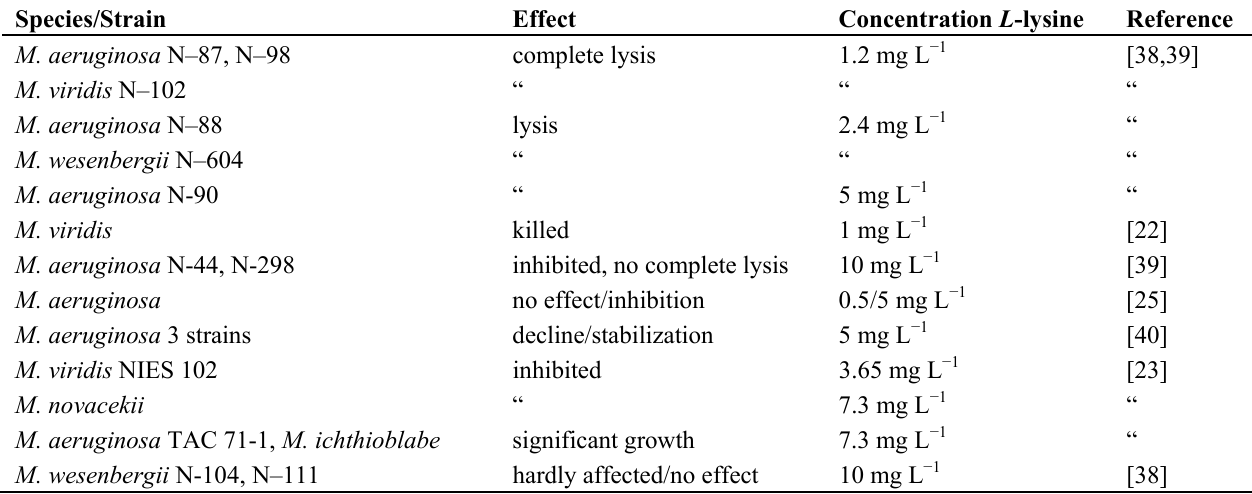
Table 6. Overview of effects or no effects of L - lysine on various Microcystis strains reported in the